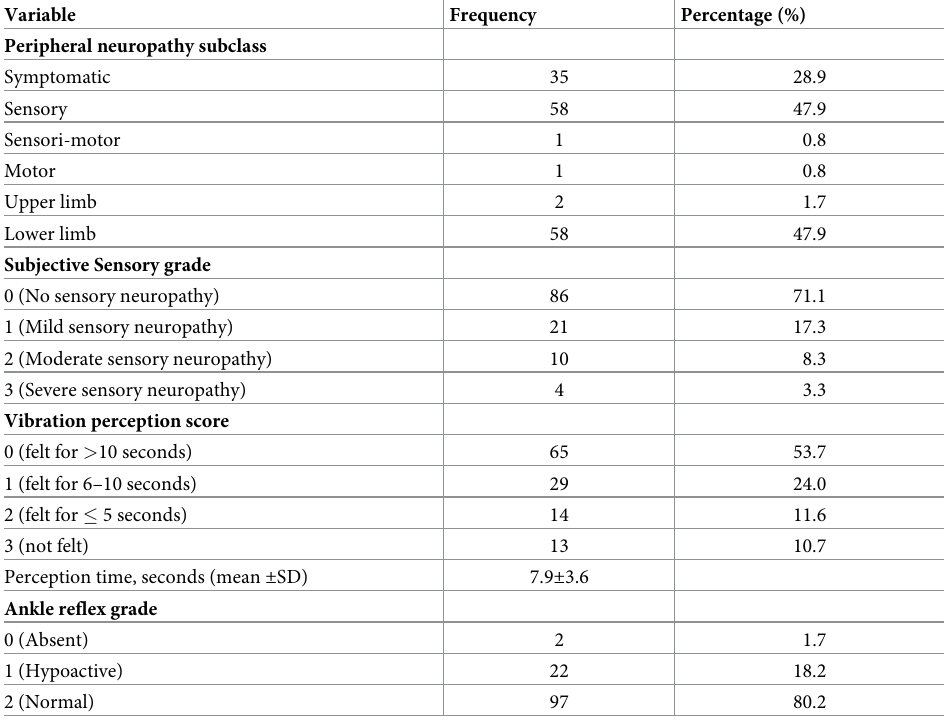
Table 6. Peripheral neuropathy assessment